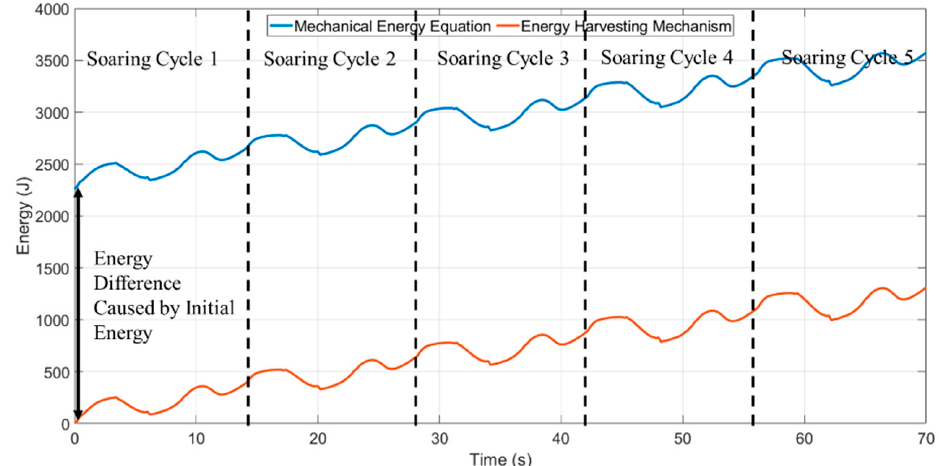
Figure 20. The energy variation curves calculate by two methods.